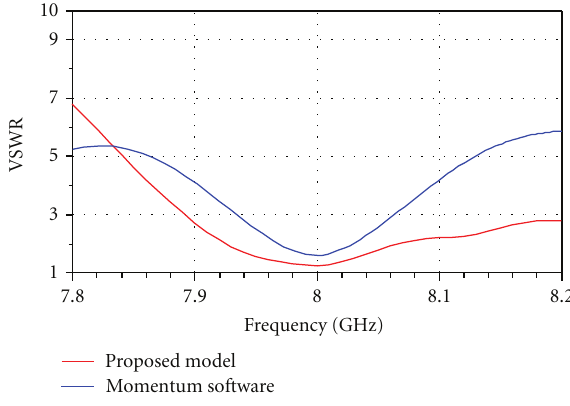
Figure 16: The antenna array input-reflected phase.